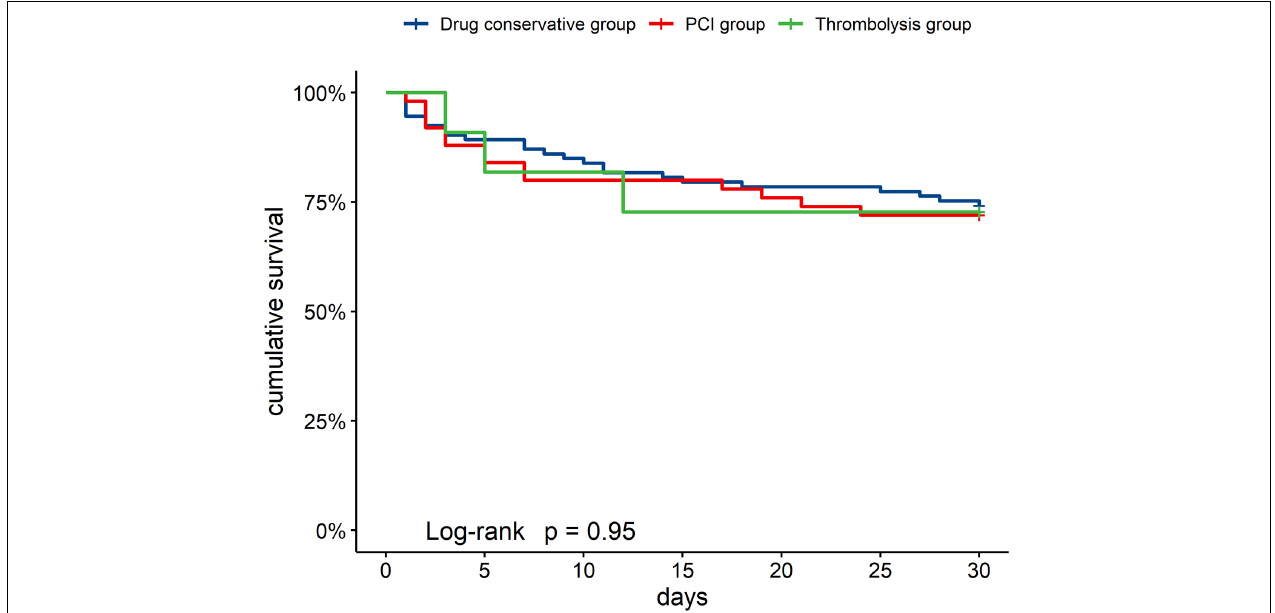
FIGURE 2 | Kaplan–Meier estimates of cumulative event-free survival for in-hospital